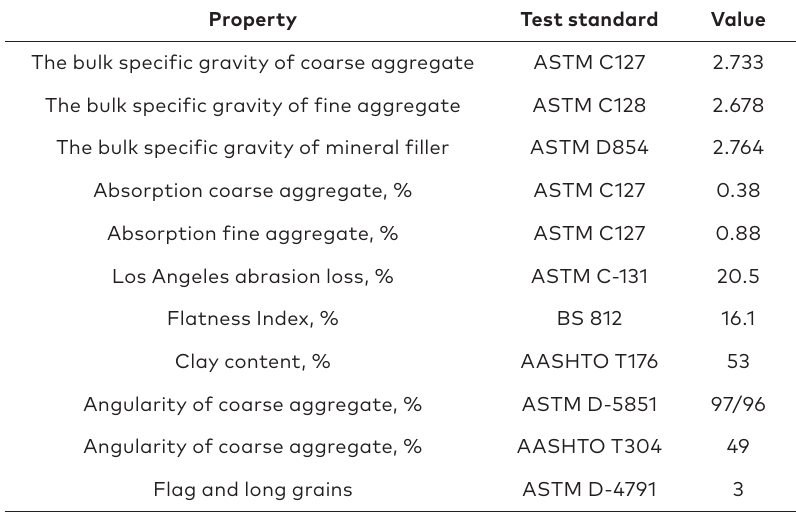
Table 6. Physical properties of aggregates in HMA